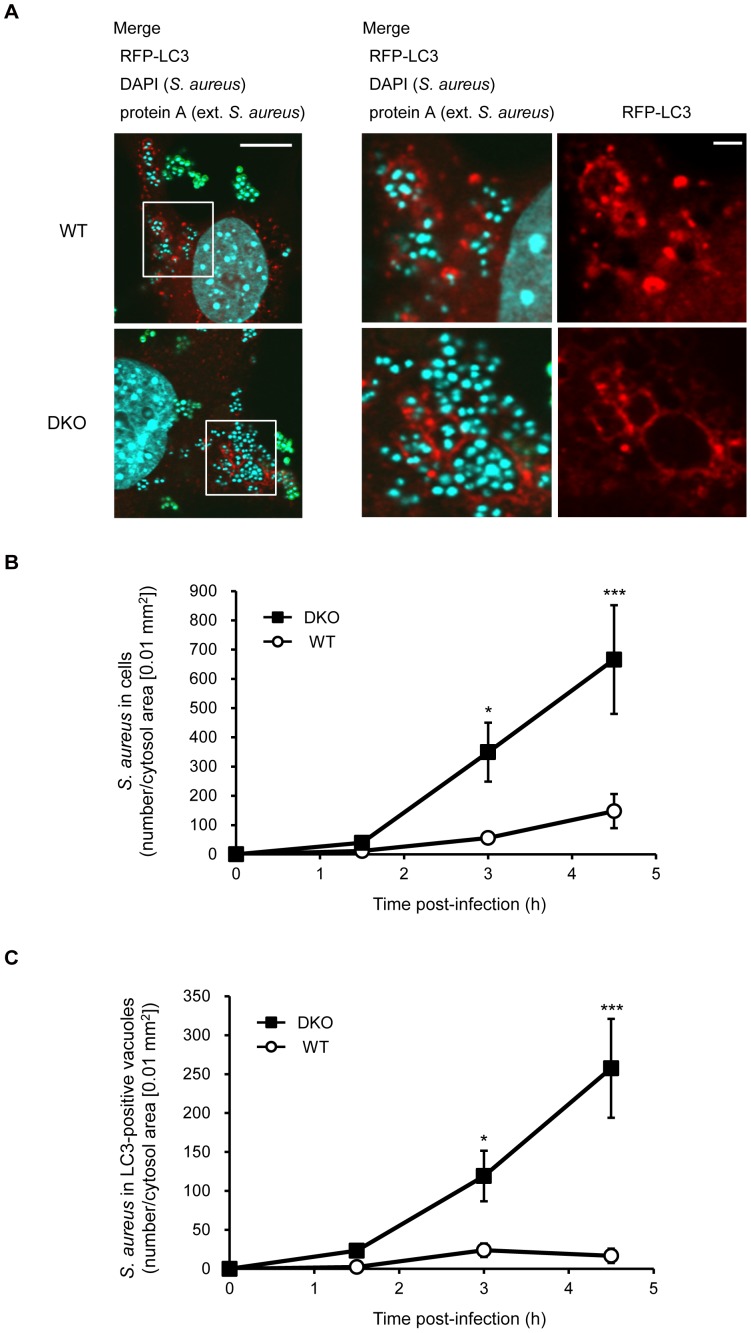

PRIP deficiency in mouse embryonic fibroblasts (MEFs) induces S. aureus accumulation in autophagosome-like vacuoles.(A–C) Comparison between S. aureus-containing autophagosome-like vacuoles in wild-type (WT) and PRIP double-knockout (DKO) MEFs. MEFs transiently expressing RFP-LC3 were incubated with S. aureus (ATCC 29213). After 1.5 h incubation, cells were washed with 100 µg/mL of gentamicin-containing medium and further incubated with gentamicin-containing medium until 3 or 4.5 h post-infection. Extracellular (ext.) S. aureus cells were immunostained with anti-protein A antibody (green), and intracellular S. aureus cells were defined as DAPI single-positive signals (A). Images at 3 h post-infection obtained by confocal laser microscopy are shown. Enlarged images of the boxed areas of the left image (scale bar: 10 µm) are shown in the middle and right images (scale bar: 2 µm). Representative images from three independent experiments are shown. The graph in (B and C) shows the numbers of intracellular S. aureus cells and of S. aureus cells localized to LC3-positive autophagosome-like vacuoles per cytosol area (0.01 mm2), respectively. Values represent means ±SEM (n = 20 cells analyzed at each time-point). Reproducible results were obtained from three independent experiments. *p<0.05 and ***p<0.001 relative to corresponding WT values.